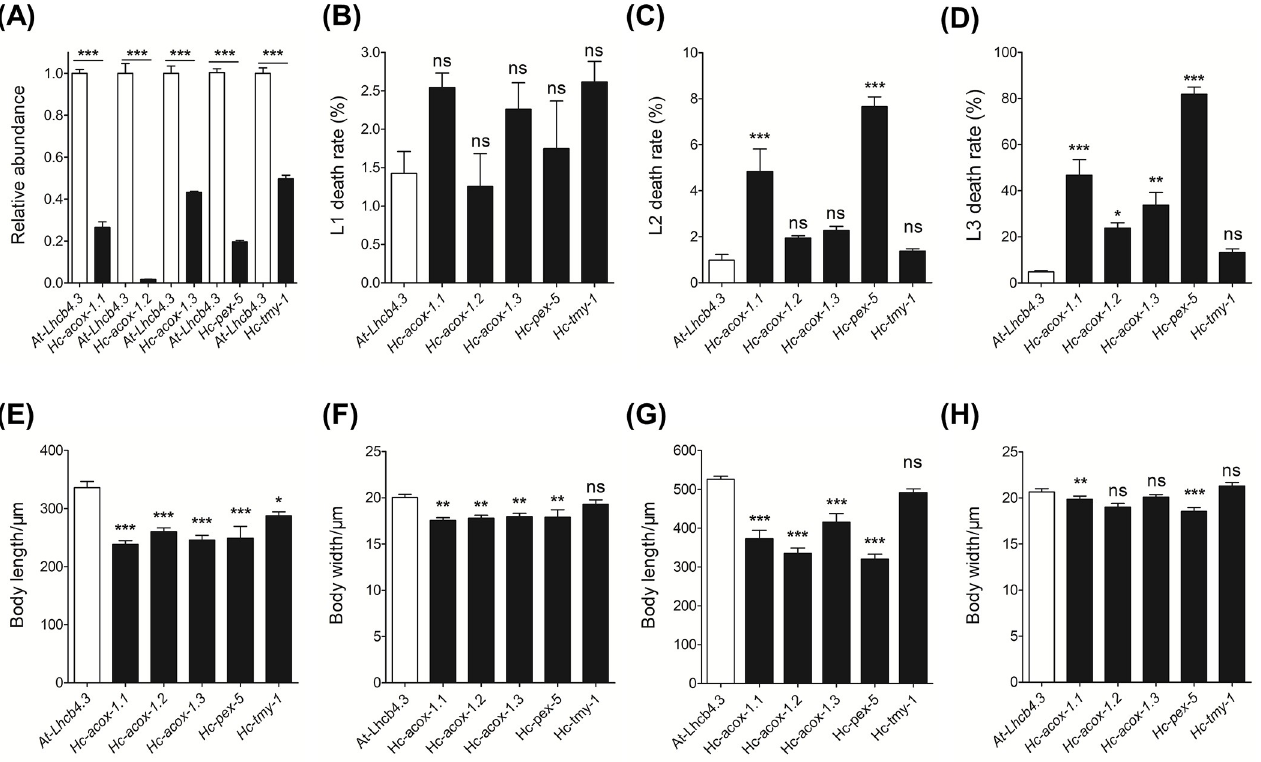
Fig 7. Effects of gene knockdown of acox-1 and pex-5 on Haemonchus contortus larval development and survival. (A) Relative transcriptional levels of Hc- acox-1 . 1 , -acox-1 . 2 , -acox-1 . 3 and - pex-5 in RNA interference (RNAi)-treated worms. Hc - β - tubulin is used as an internal control. Arabidopsis thaliana light harvesting complex gene ( Lhcb4 . 3 ) is used as a negative control. H . contortus tropomyosin ( Hc-tmy-1 ) is used as a positive control. The relative abundance of each transcripts in treated worms is compared with that of the negative control. (B-D) Death rates of the first- (L1, B), second- (L2, C) and third- (L3, D) stage larvae of RNAi-treated worms. (E-F) Changes in body length (E) and body width (F) of RNAi-treated L2s of H . contortus . (G-H) Changes in body length (G) and body width (H) of RNAi-treated L3s of H . contortus . Data in all panels are presented in mean ± SEM (n = 20). Statistical analysis is performed using one- way ANOVA with Dunnett post-hoc test. � P < 0.05, �� P < 0.01, ��� P < 0.001, ns: no significance.